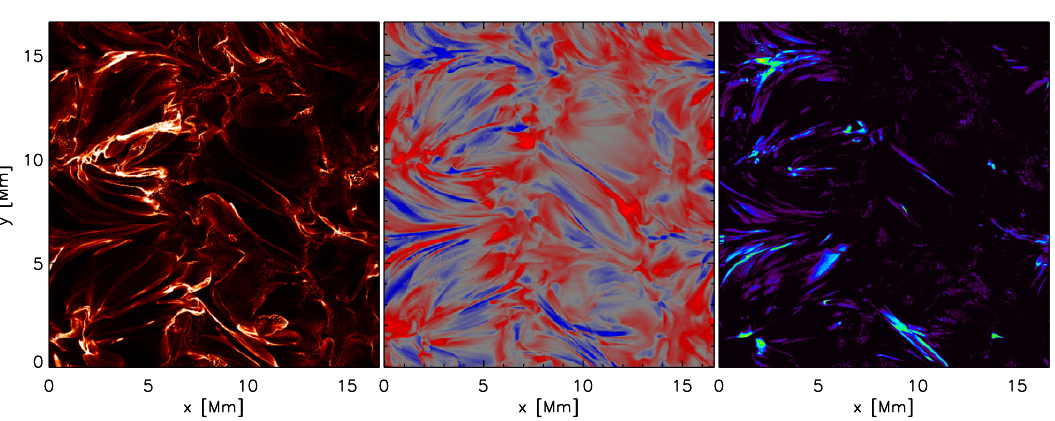
Figure 19: Maps of intensity (left), Doppler shift (middle) and line width (right) in the C iv line in a 3-D MHD simulation of a box of the upper solar atmosphere. The velocity scale is from –40 km s –1 (blue) to 40 km s –1 (red). Line widths range from narrow black to wide yellow/red with a maximum of 51 km s –1 . The average line-shift in the C iv line is 6.6 km s –1 (redshift is positive). Image reproduced with permission from Hansteen et al. (2010), copyright by